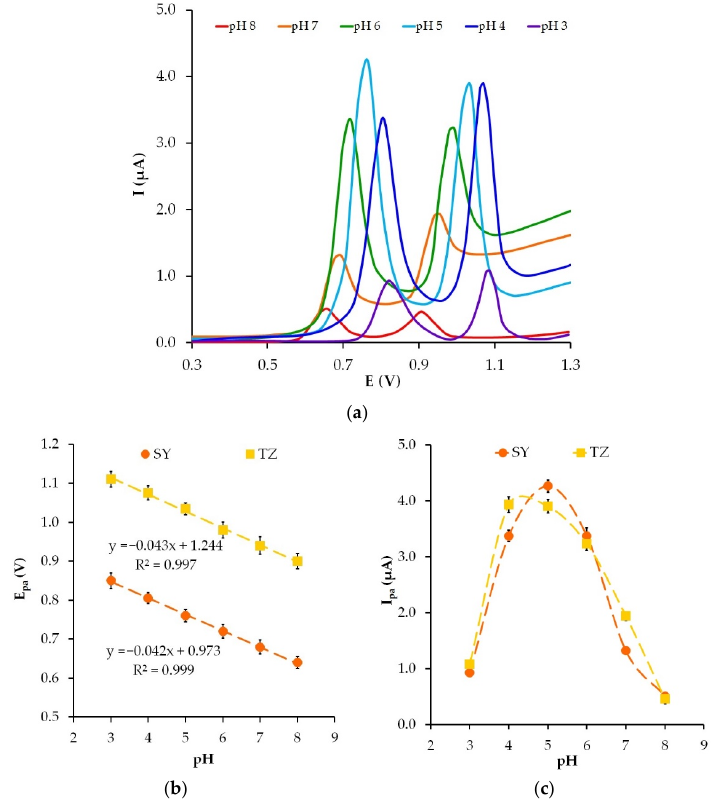
Figure 7. Linear sweep voltammograms of 10 μ M SY and 10 μ M TZ on GrP/CP electrode in phos- phate buffer solution at different pH at the scan rate of 50 mV s − 1 ( a ), the effects of pH on the anod-